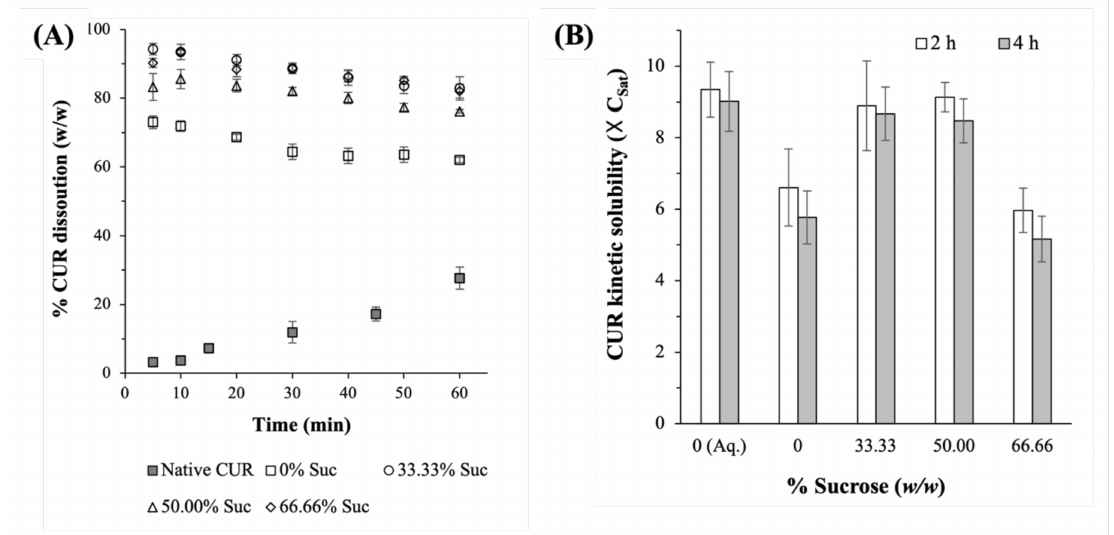
Figure 4. ( A ) CUR dissolution profiles and ( B ) amorphous CUR kinetic solubility of the lyophilized CUR-BSA nanoplexes prepared at different sucrose mass fractions. (“Suc” = sucrose and “Aq.” = aqueous